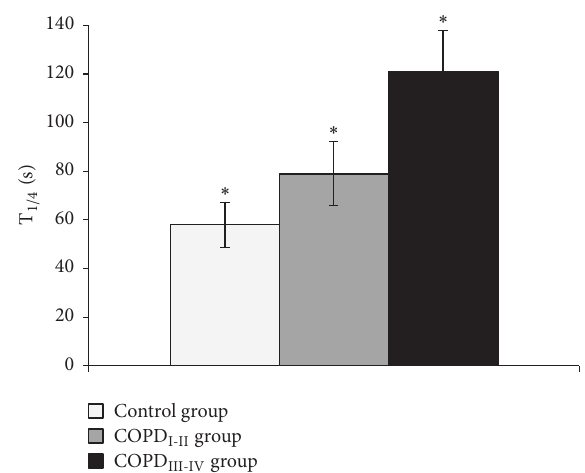
Figure 2: Bar graph of the mean values of quarter-time of recovery in oxygen uptake (T 1/4 ) according to groups. COPD: chronic obstructive pulmonary disease. ∗ significantly different from both groups ( 𝑝 < 0.01